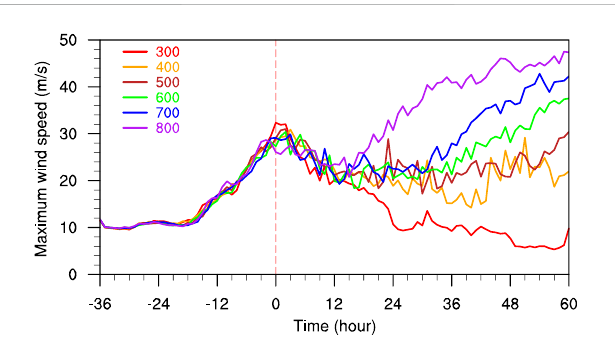
FIGURE 3 Time series of maximum surface winds of the experiments (m s − 1 ). The red dashed line indicates the imposed shear time. The red, orange, brown, green, blue, and purple solid lines indicate the intensity changes ofTCsinEXP300,EXP400,EXP500, EXP600,EXP700,andEXP800, respectively.